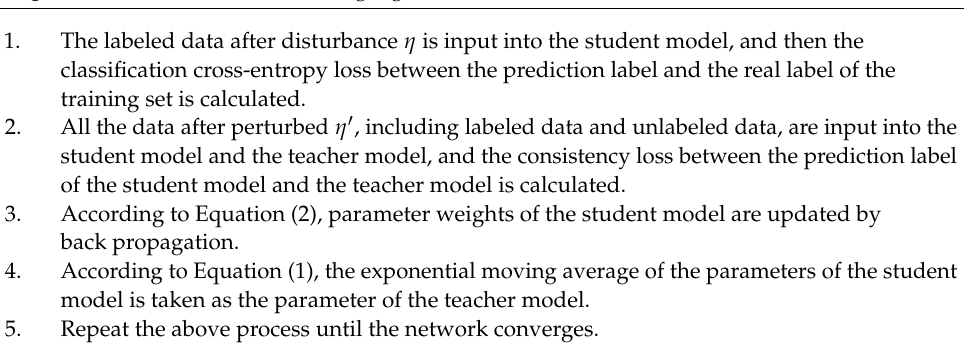
Algorithm 1. Mean Teacher learning